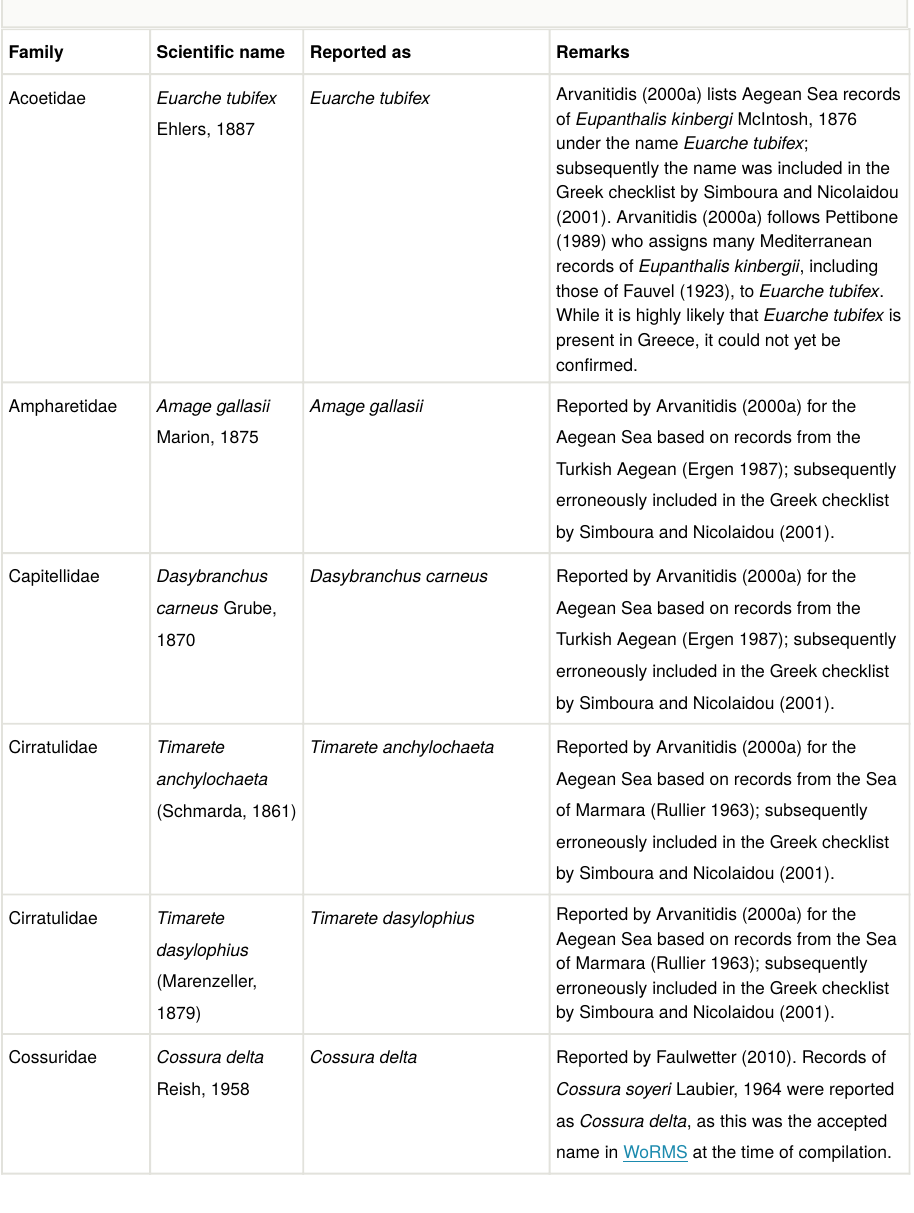
Species reported from Greece in previous publications but in fact absent from the area, with unclear identity (e.g. nomina dubia ), or wrongly